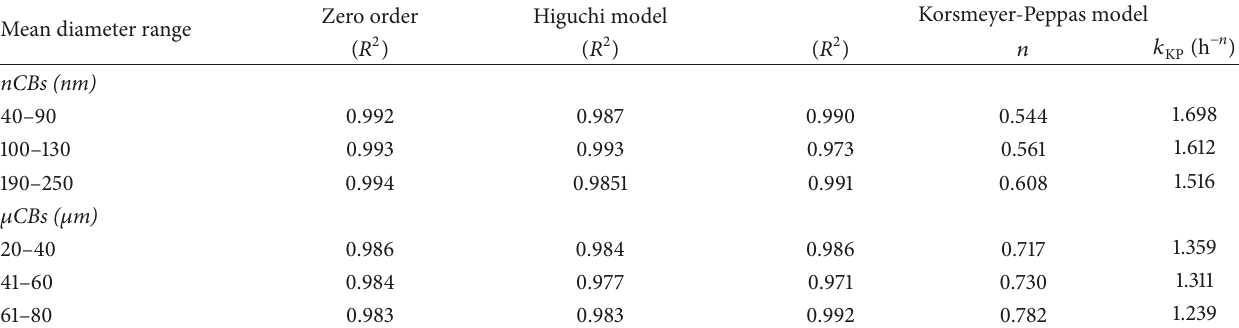
Table 2: Release kinetic parameters of curcumin from cellulose beads of different mean diameter